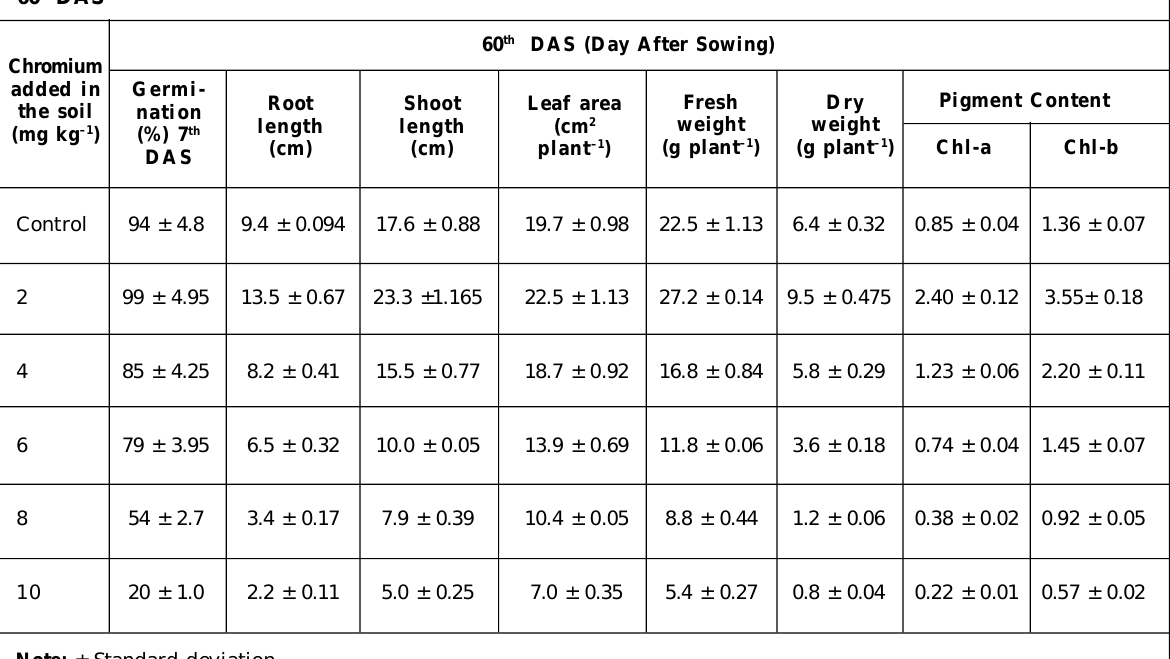
Table 1 represent the maximum shoot length (23.3 ± 1.165) root length (13.5 ± 0.67) on 60 DAS respectively